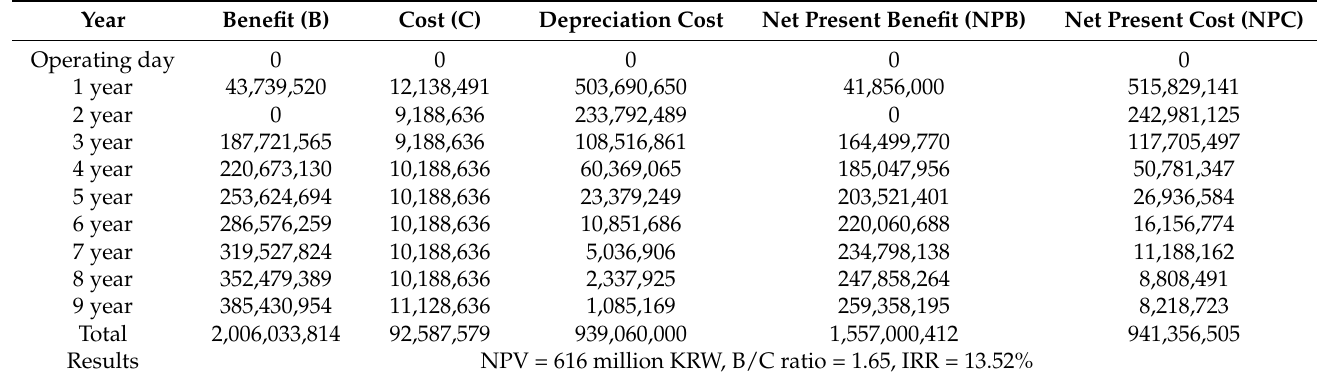
Table 4. Results of cash flow and cost-benefits